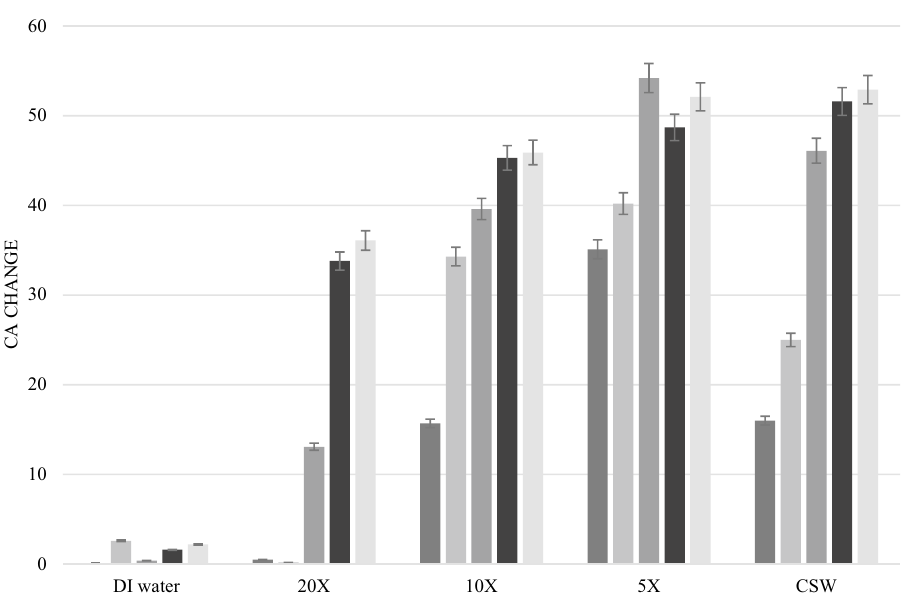
Fig. 3 Change in contact angle